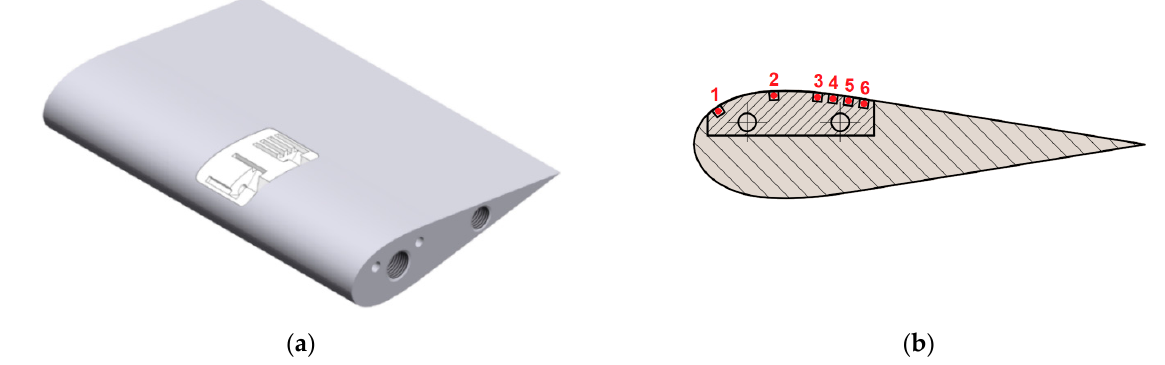
Figure 9. ( a ) 3D view of hydrofoil with thermistor holder; ( b ) cross-section of hydrofoil with thermistors 1–6.